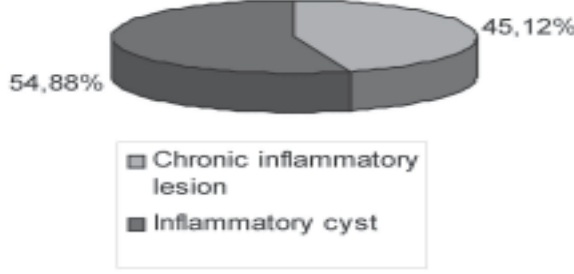
FIGURE 2- Percentage of chronic inflammatory lesions